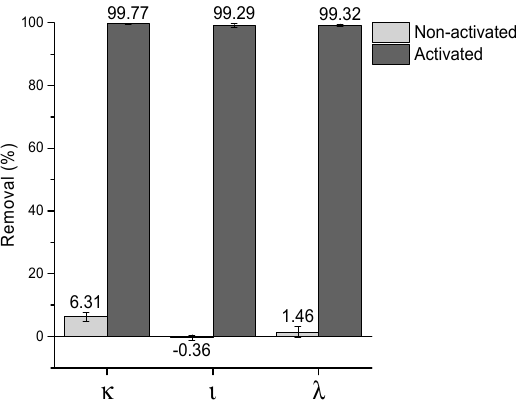
Figure 6. The performance of the hydrochars and activated carbons for the removal of ciprofloxacin from water (conditions: 50 mg/L CIP, pH = 5, 24 h contact time, sorbent dosage: 0.5 mg/mL).